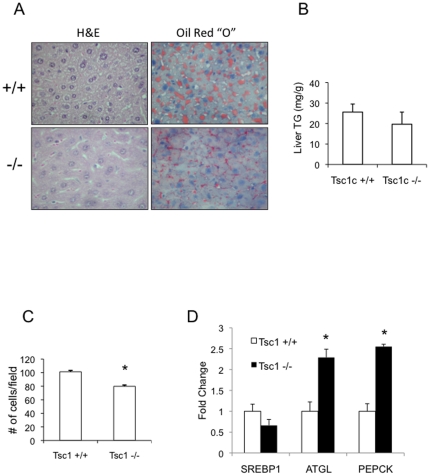
mTORC1 activity is not sufficient for steatosis.Normal chow-fed, 20-week old male Tsc1+/+ and Tsc1−/− male mice were fasted overnight and sacrificed. Liver tissues were processed for histologic and biochemical analyses. A) Liver histology (H&E) and Oil Red “O” staining showing hepatic morphology and lipid content. Magnification 400X. B) Quantification of liver triglyceride content using TG assay kit (Roche Diagnostics, see Methods). C) Hepatocyte cell size was deduced based on the average number of hepatocytes per high-power field from 10 randomly selected fields. *, p<0.01 compared to Tsc1+/+. D) Expression of genes involved in lipogenesis (SREBP1), adipogenesis (PPARg), lipolysis (ATGL) and gluconeogenesis (PEPCK) were determined by quantitative RT-PCR. *, p<0.05 compared to Tsc1+/+. For all graphs, values represent mean ±SEM.